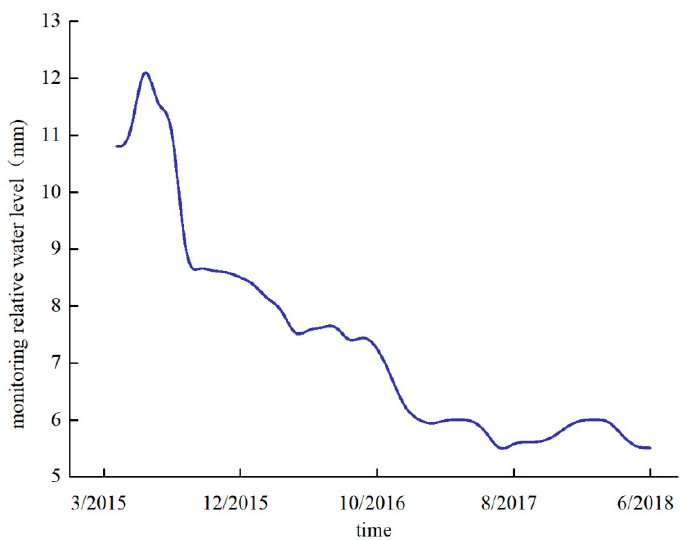
Figure 7. Groundwater depth level change from 2015.03 to 2018.06.